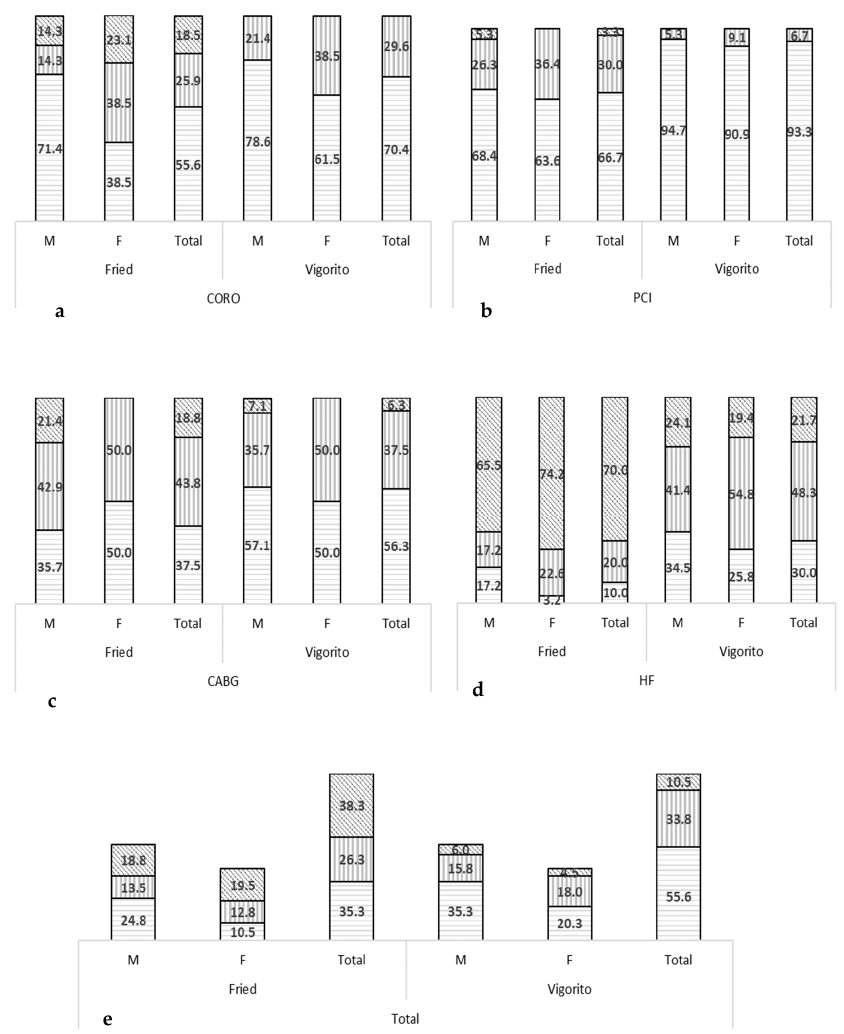
Figure 1. Distribution of the different levels of frailty (%) according to Fried and Vigorito for male and female CORO ( a ), PCI ( b ), CABG ( c ) and HF ( d ) patients. The different levels of frailty are represented as no frailty (horizontal lines), pre-frailty (Fried) or mild frailty (Vigorito) (vertical lines) and frailty (Fried) or moderate frailty (Vigorito) (diagonal lines). Note: Severe frailty (Vigorito) was not detected in the subjects and, thus, are not represented in the figure. Results are expressed as % within males and within females per CVD for each subcategory of frailty (in CORO, PCI, CABG and HF patients) or as % within CVD for total results (in CORO, PCI, CABG and HF patients) or as % within total population (for total results in last graph) ( e ). CABG, coronary artery bypass grafting; CORO, coronarography; F, females; HF, heart failure; M, males; PCI, percutaneous coronary inter- vention.